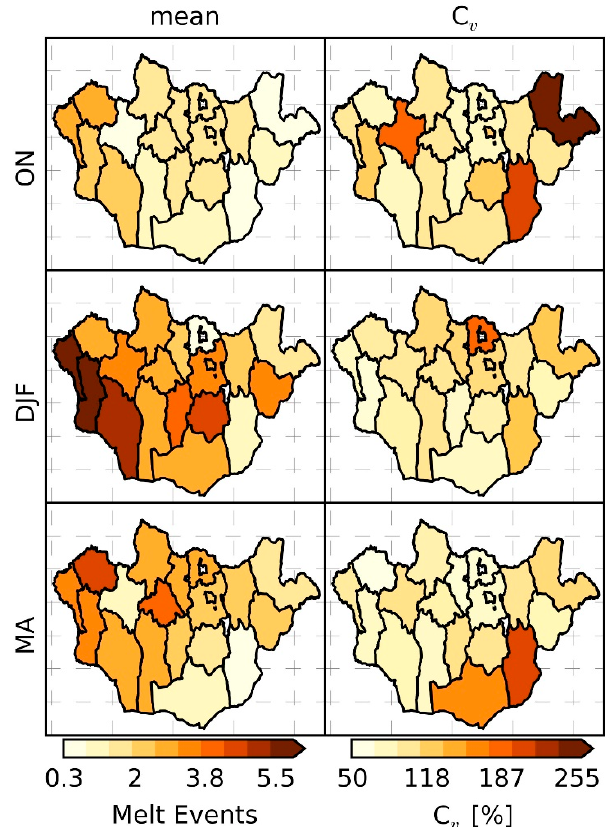
Figure 7. The mean and coefficient of variation (C v ) in the number of anomalous melt events for each aimag and season during WY 2003–2016 in Mongolia; the images represent aggregated monthly results for fall (ON), winter (DJF) and spring (MA).